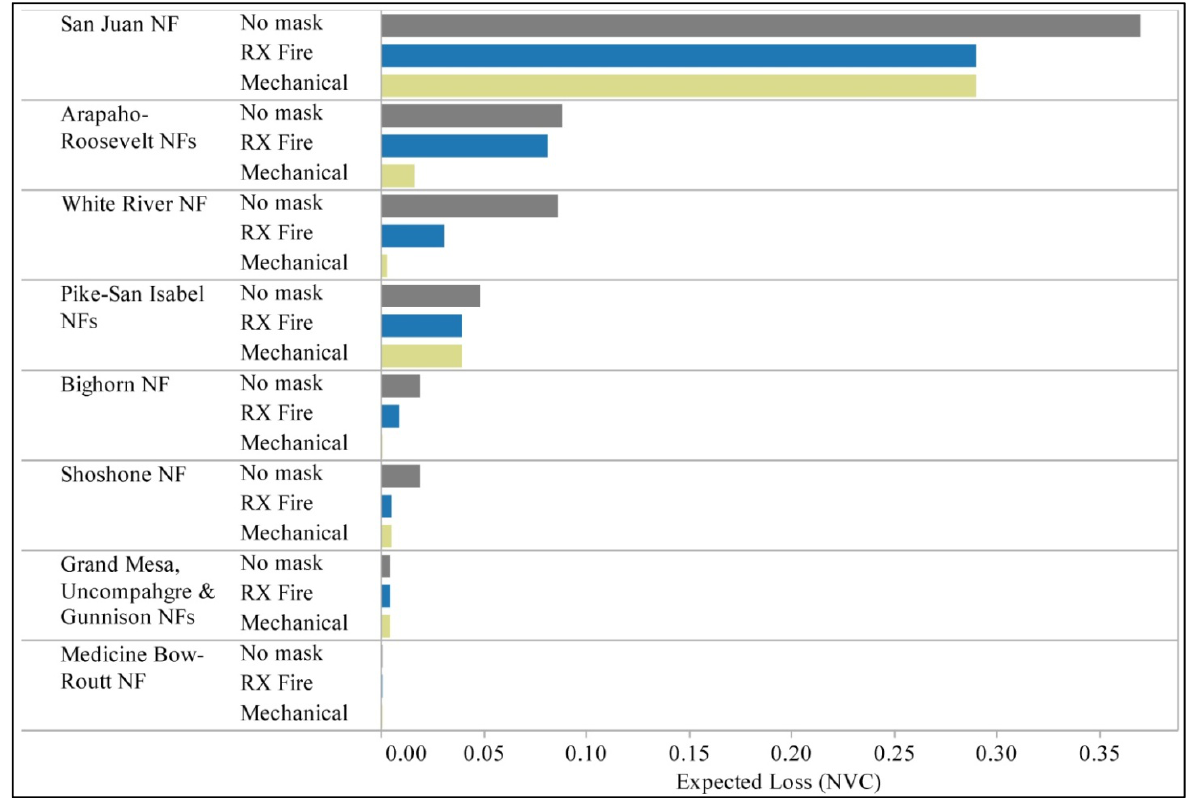
Figure 9. Expected loss summarized at the forest-level, and filtered according to spatial treatment opportunities [See Equation (3)]. RX Fire = Prescribed fire; NF = National